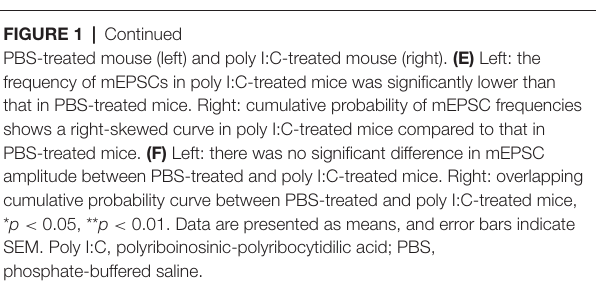
FIGURE 1 | Continued PBS-treated mouse (left) and poly I:C-treated mouse (right). (E) Left: the frequency of mEPSCs in poly I:C-treated mice was significantly lower than that in PBS-treated mice. Right: cumulative probability of mEPSC frequencies shows a right-skewed curve in poly I:C-treated mice compared to that in PBS-treated mice. (F) Left: there was no significant difference in mEPSC amplitude between PBS-treated and poly I:C-treated mice. Right: overlapping cumulative probability curve between PBS-treated and poly I:C-treated mice, * p < 0.05, ** p < 0.01. Data are presented as means, and error bars indicate SEM. Poly I:C, polyriboinosinic-polyribocytidilic acid; PBS, phosphate-buffered